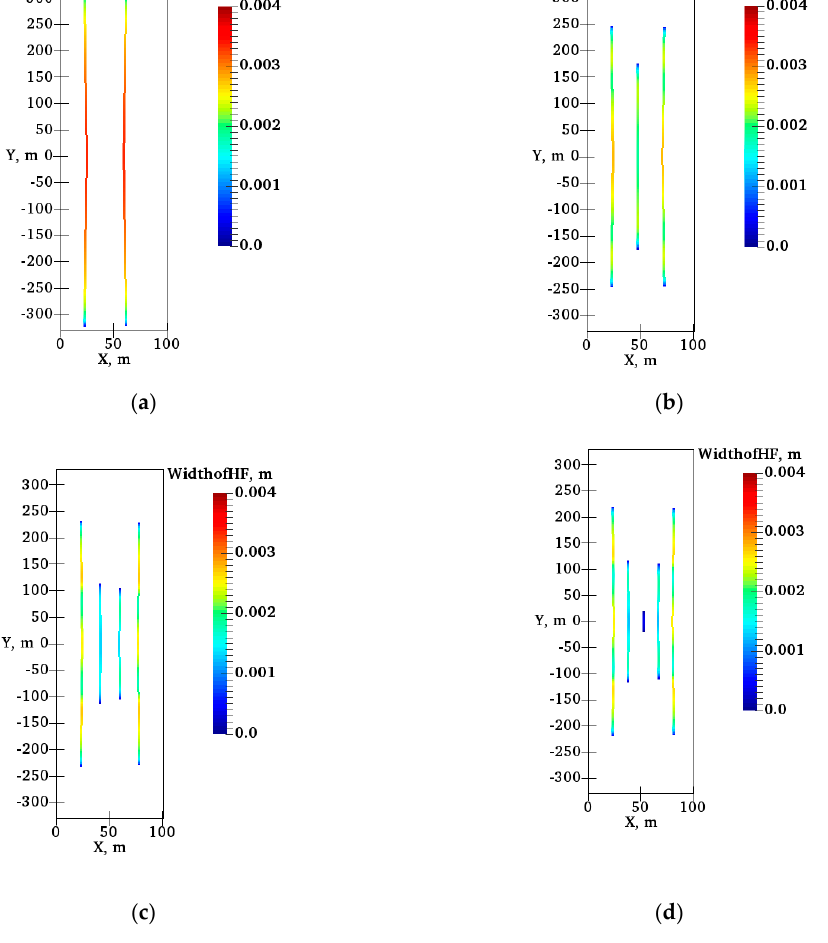
Figure 9. Effects of different numbers of fracture within the stage on the fracture geometry: ( a ) 2; ( b ) 3; ( c ) 4; and ( d ) 5. Table 6. The results of fracture length affected by different number of fractures within the stage. Number of Fractures within the